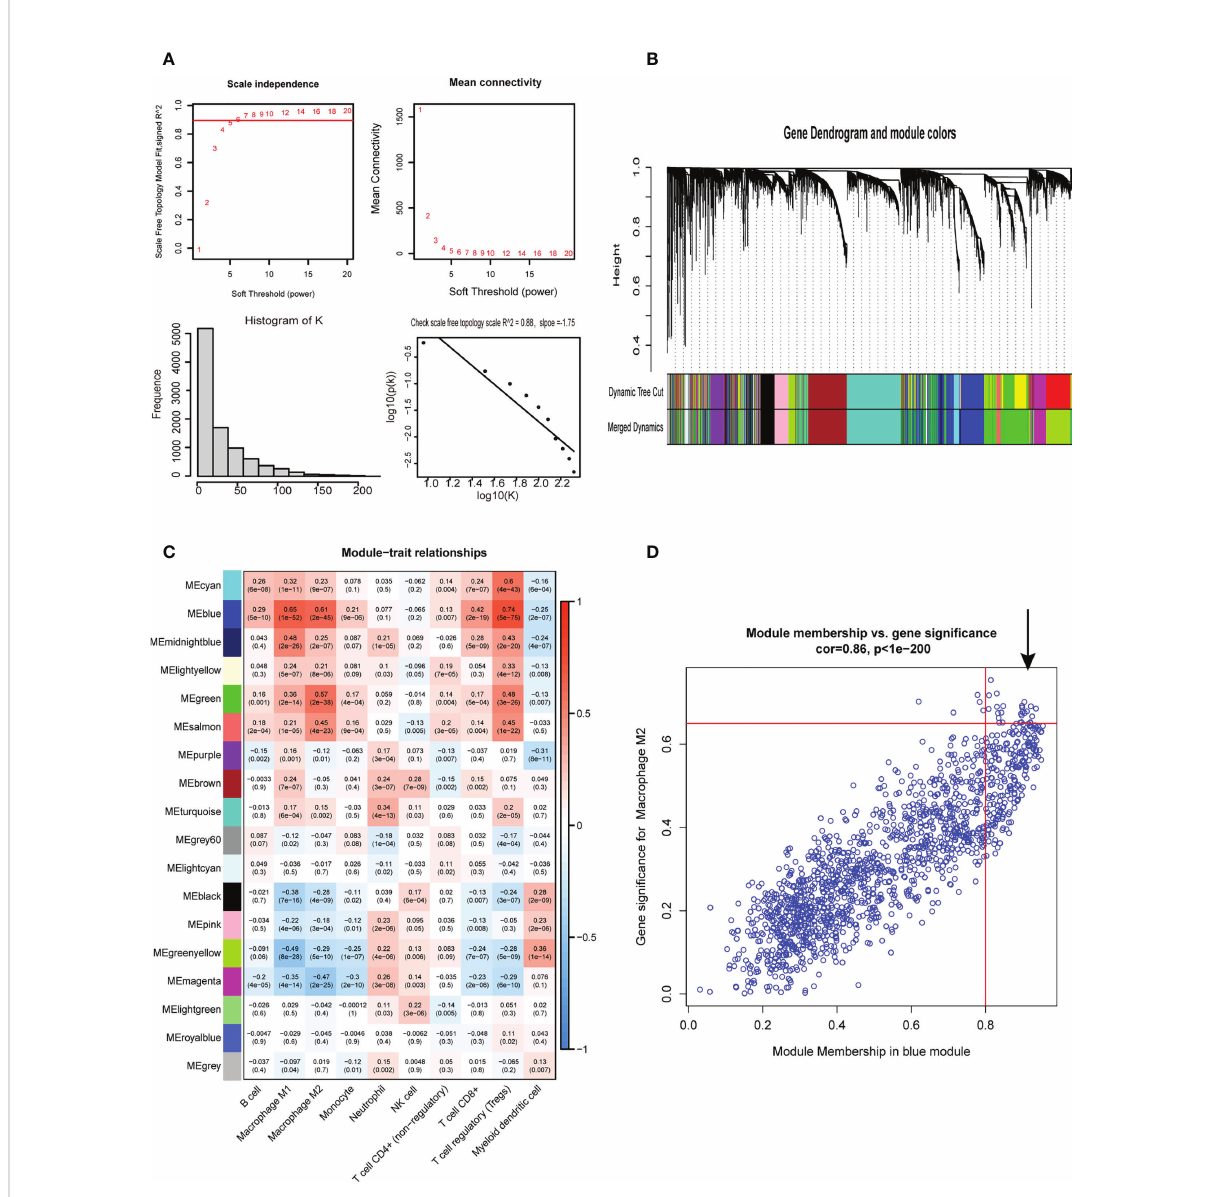
FIGURE 3 Weighted gene co-expression network analysis. (A) Screening for suitable soft thresholds and scale-free network validation. The soft threshold is selected as 5, the distribution curve and network connectivity k, which represented a satisfactory scale-free network. (B) The cluster dendrogram with the gene modules and module merging. (C) The correlation between gene modules and immune cell fraction. (D) The correlation between GS and MM shown in scatter plot in blue